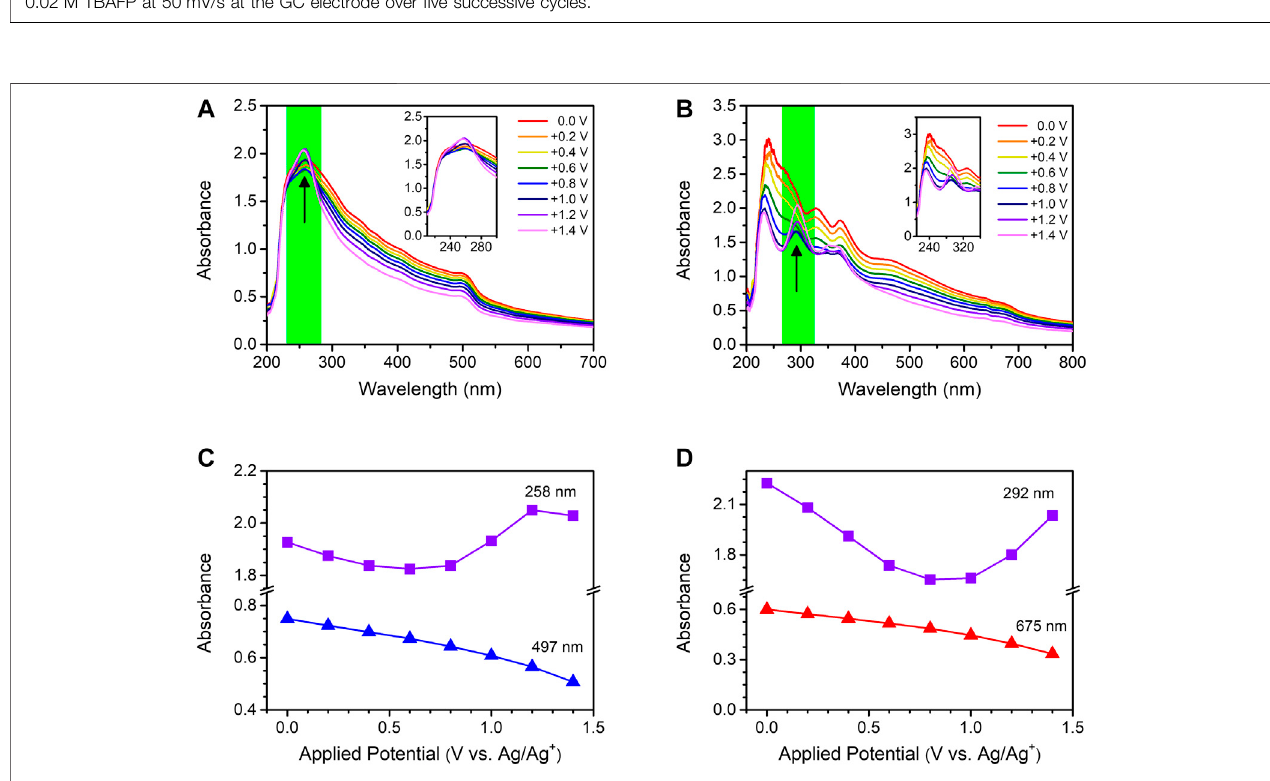
Frontiers in Energy Research |